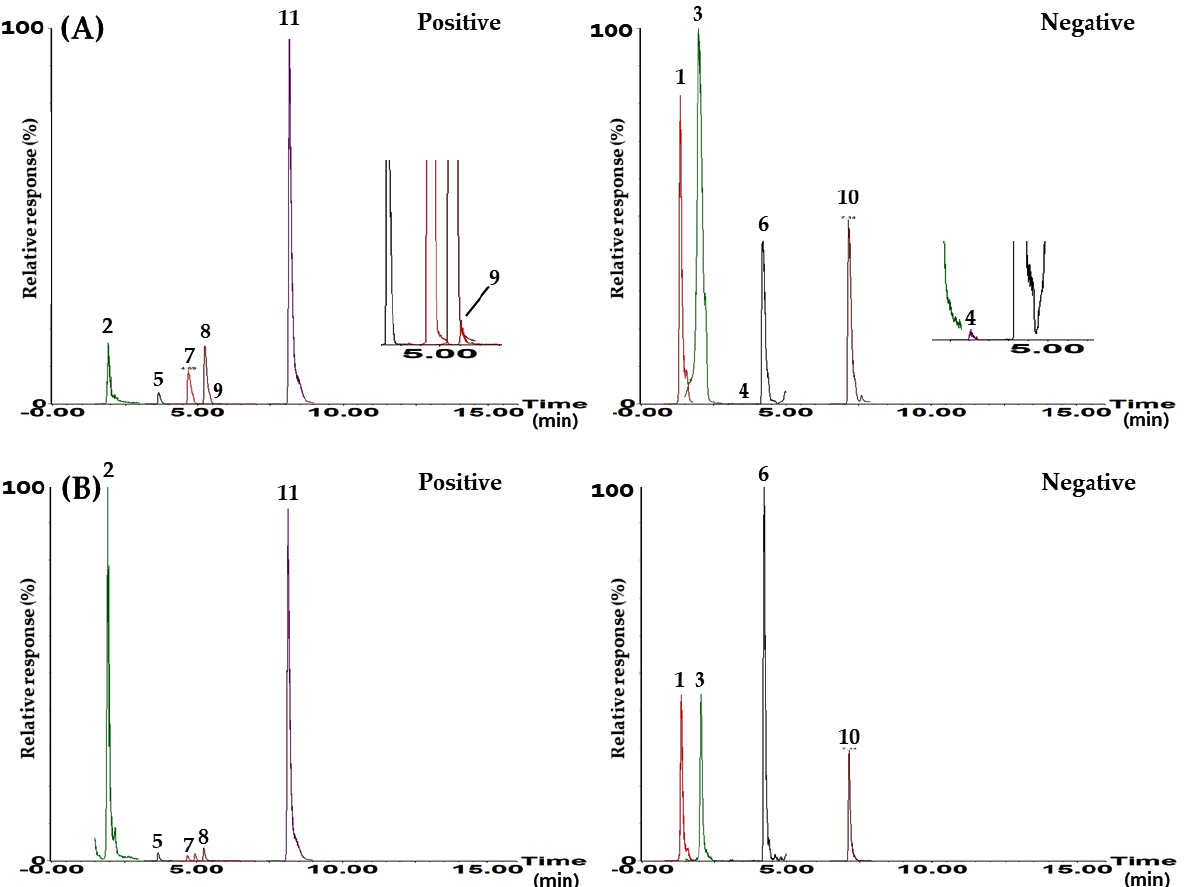
Figure 2. Total ion chromatograms of the mixed reference standard ( A ) and GGSGH sample ( B ) using LC – MS/MS MRM mode. Gallic acid ( 1 ), 5-(hydroxymethyl)furfural ( 2 ), geniposidic acid ( 3